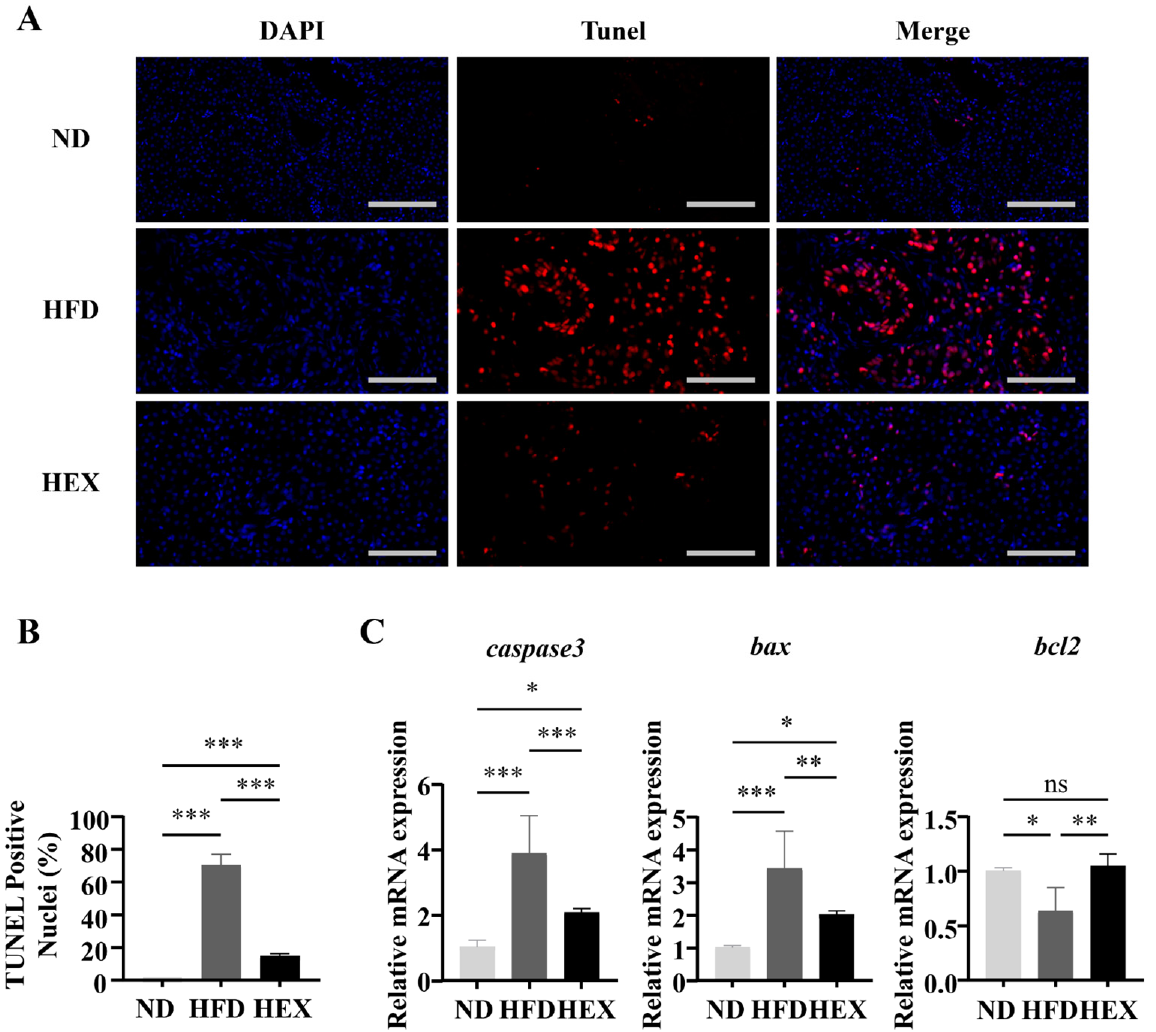
Figure 5. Hepatocyte apoptosis in 9-month-old zebrafish livers. ( A ) Tunel staining of zebrafish livers, and ( B ) Quantitation of Tunel-positive cells ( n = 3). ( C ) Gene expression of caspase3 , bax , and bcl2 ( n = 6). *, p < 0.05 **, p < 0.01, ***, p < 0.001. Data represent the mean, and error bars represent SEM. Scale bar, 20 µ m. NAFLD, non-alcoholic fatty liver disease; ND, normal diet; HFD, high fat diet; HEX, high-fat diet plus exercise.